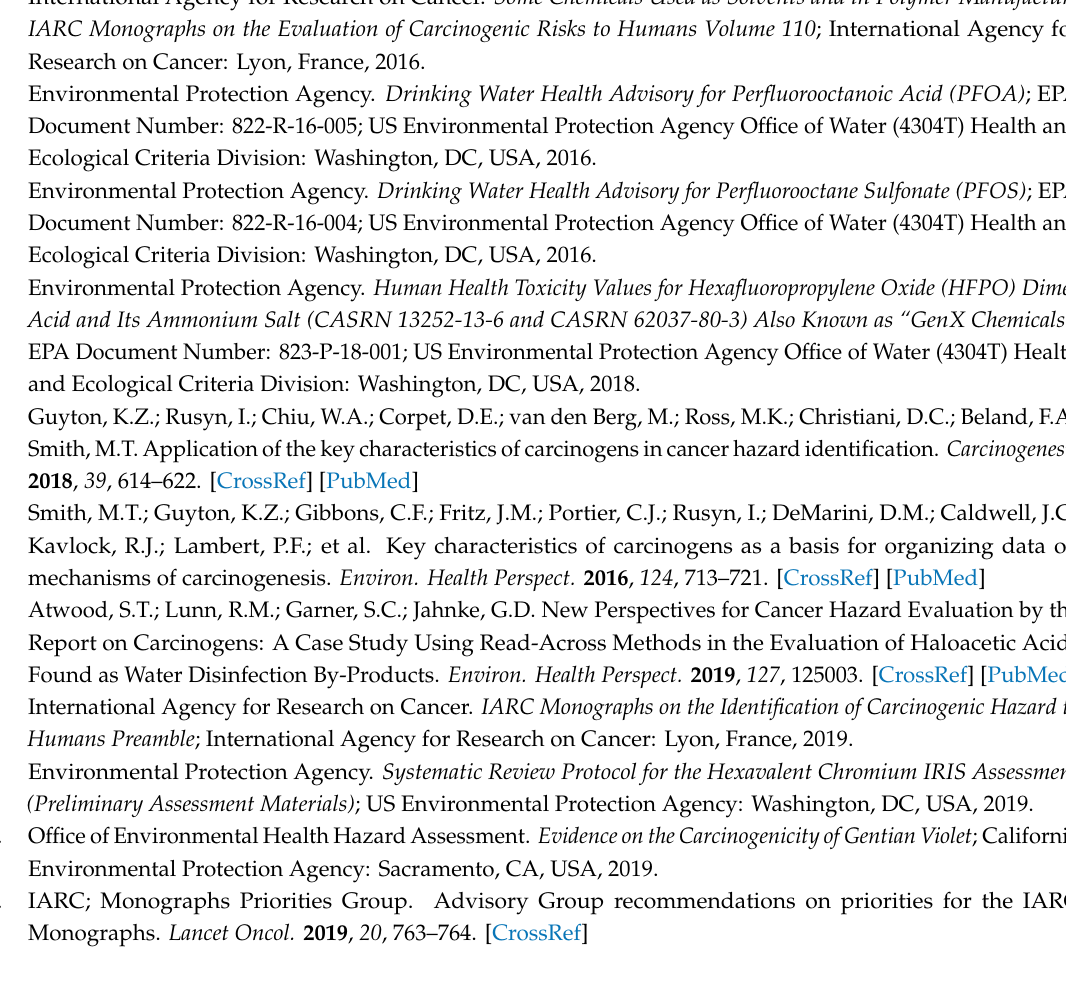
Table S1: List of abbreviations for reviewed PFAS and data availability for key